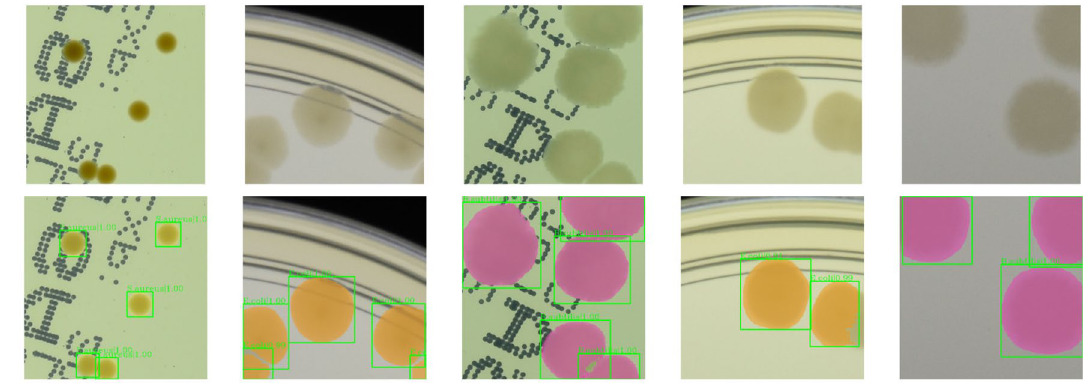
Figure 8. Example results for instance segmentation of real samples in case of different microbial species.